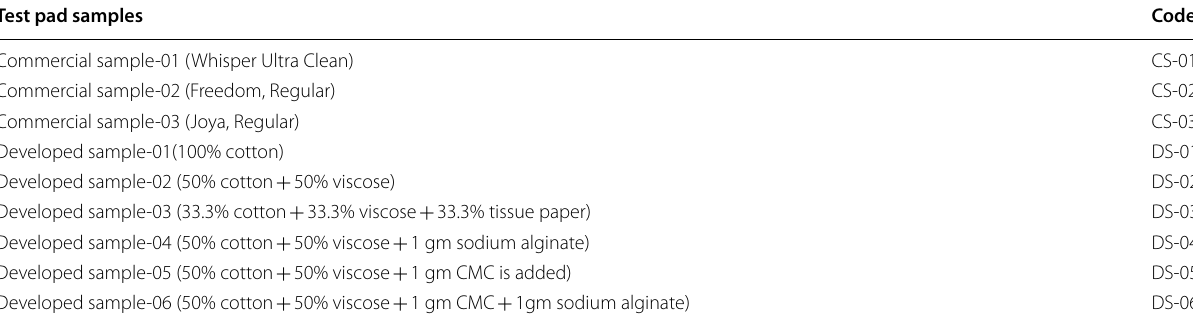
Table 1 Test pad samples coding Test pad